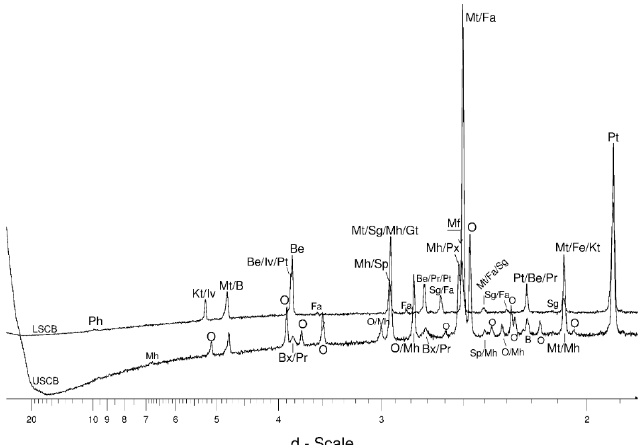
Figure 4. Final results of heating the two sideritic samples collected from the Upper- and the Lower Silesian Coal Basins. Gt—gibbsite, Iv—ilvaite, Kt—katoite?, Mf—magnesioferrite, Pr—perovskite, Sg—“skiagite”. Other symbols and explanations as in Figures 1–3.